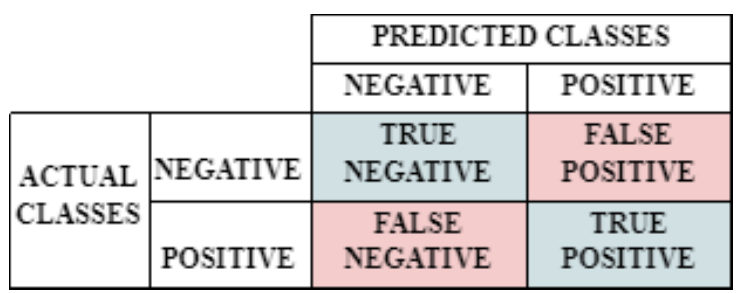
Figure 8. Confusion matrix.